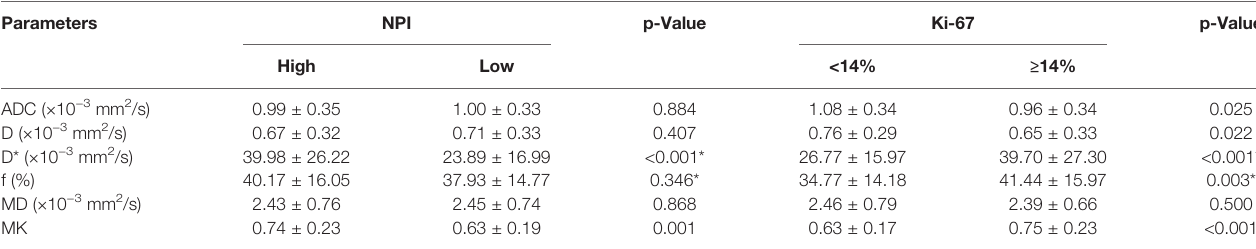
TABLE 2 | Diagnostic performance of DWI, DKI, and IVIM parameters in different prognostic factors of breast cancer.